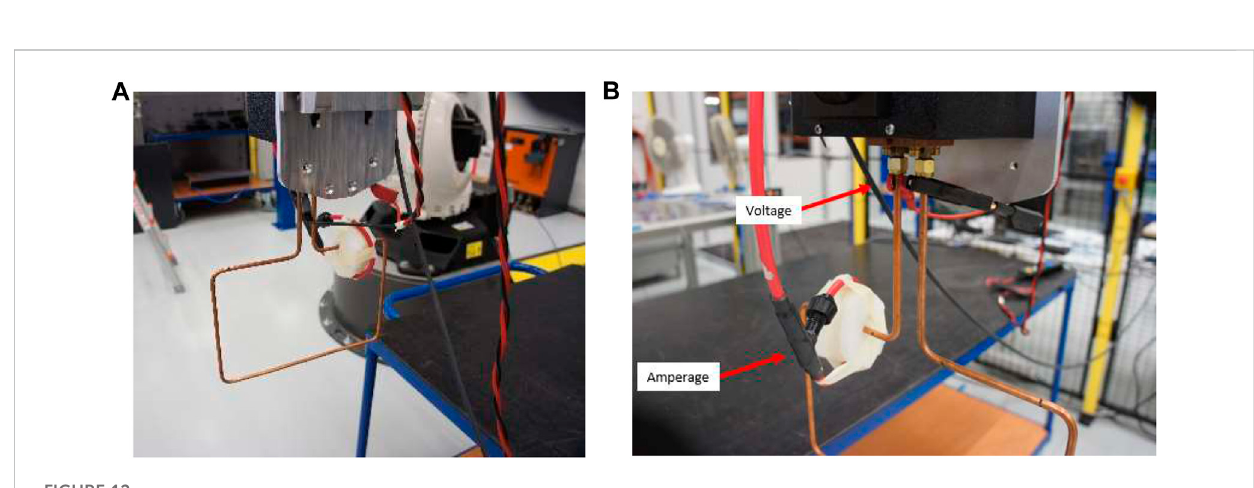
FIGURE 12 (A) Measurement of the Voltage and (B) Amperage applied to the